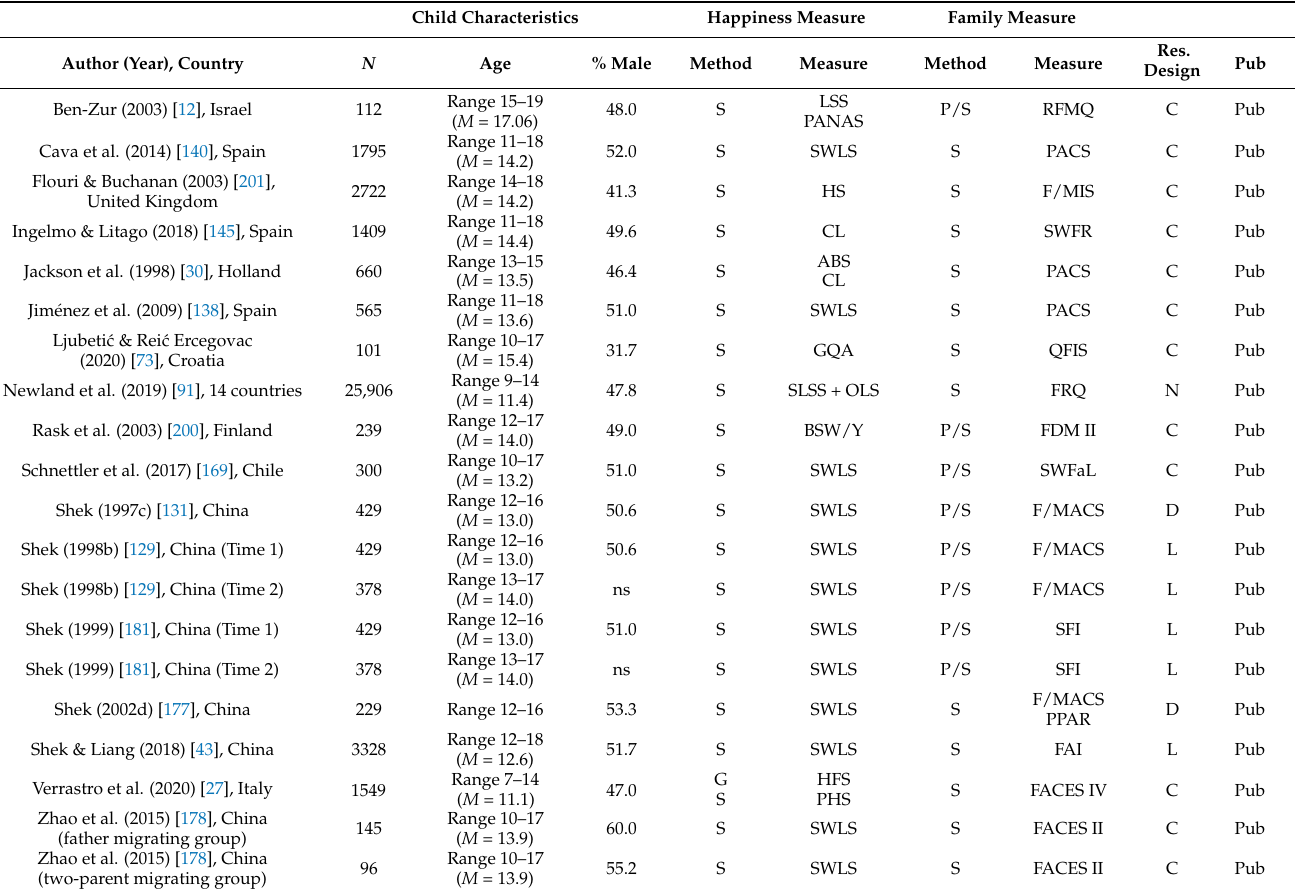
Table 3. Sample Characteristics and Methods of Assessment of the Reviewed Studies Investigating the Parental Differences ( n =